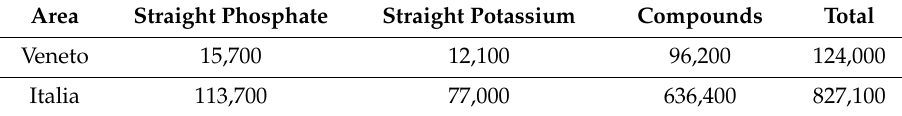
Table 2. Fertilizers quantities spread in Veneto and in Italy in 2015 (10 3 kg / y) [20].